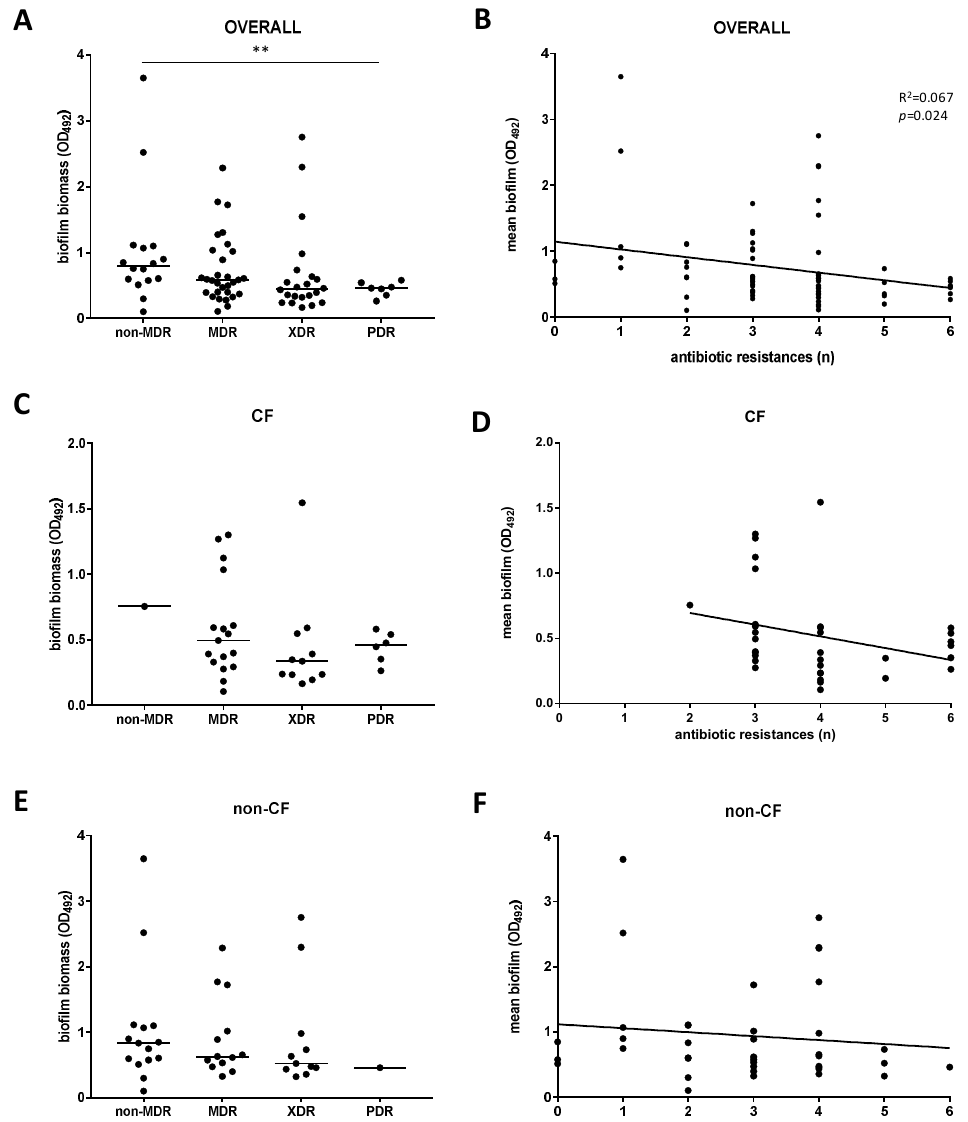
Figure 5. Biofilm formation according to the antibiotic resistance level. Biofilm formation was measured by crystal violet assay, and antibiotic resistance by disk diffusion technique. Biofilm formation was stratified according to ( A , C , E ) the resistance phenotype (non-MDR, MDR, XDR, PDR)— showing results as scatter plot, with the horizontal line indicating the median value—and ( B , D , F ) the number of resistances to each antibiotic tested. Significance level: ** p < 0.01, Mann—Whitney test; r 2 : 0.067, p = 0.024, linear regression analysis.